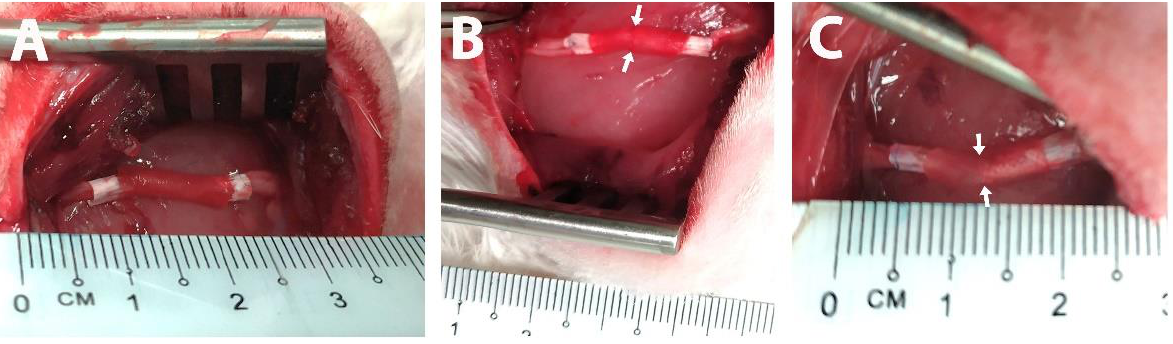
Figure 6. Photographs of the surgery after the insertion of the implants. ( A ) Unimodular conduit (UMC). ( B ) Multimodular conduit (MMC). ( C ) Multimodular conduit with pre-seeded human Schwann cells (MMC + hSC). In white are the end bands employed for the insertion and suture of the distal and proximal nerve stumps. The total length of the implants (one conduit for the UMC group and two conduits for the MMC and MMC + hSC groups) was 20 mm, including the 2.5 mm- long end bands. The length of the nerve gap was 15 mm. The arrows in B and C indicate the sepa- ration between both HA modules.